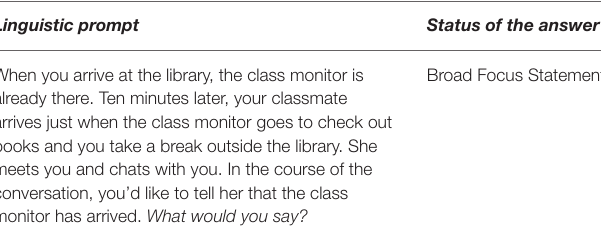
TABLE 2 | Sample of one of the discourse contexts that served as a prompt for the DCT for the control sentence in the BROAD FOCUS